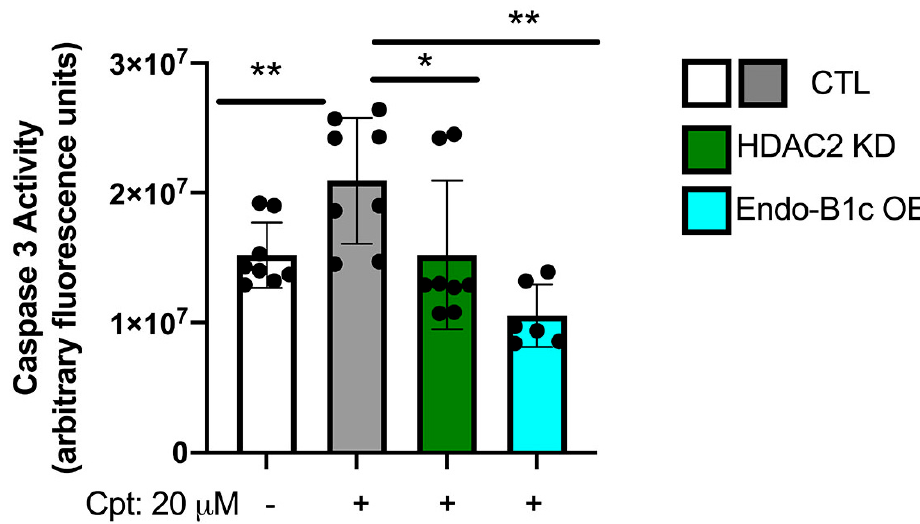
Figure 6. HDAC2 KD and OE of Endo-B1c in hiPSC-derived neurons is protective against neuronal stress. hiPSC-derived neurons were treated for 24 h with 20 µ M camptothecin. Cell death was quantified by measuring caspase-3 activity. Each dot represents a technical replicate of 3–4 independent experiments. Analysis compares all groups to the CTL/untreated bar (white) using a one-way ANOVA with Tukey post hoc multiple comparisons; ** p < 0.01; * p < 0.05.